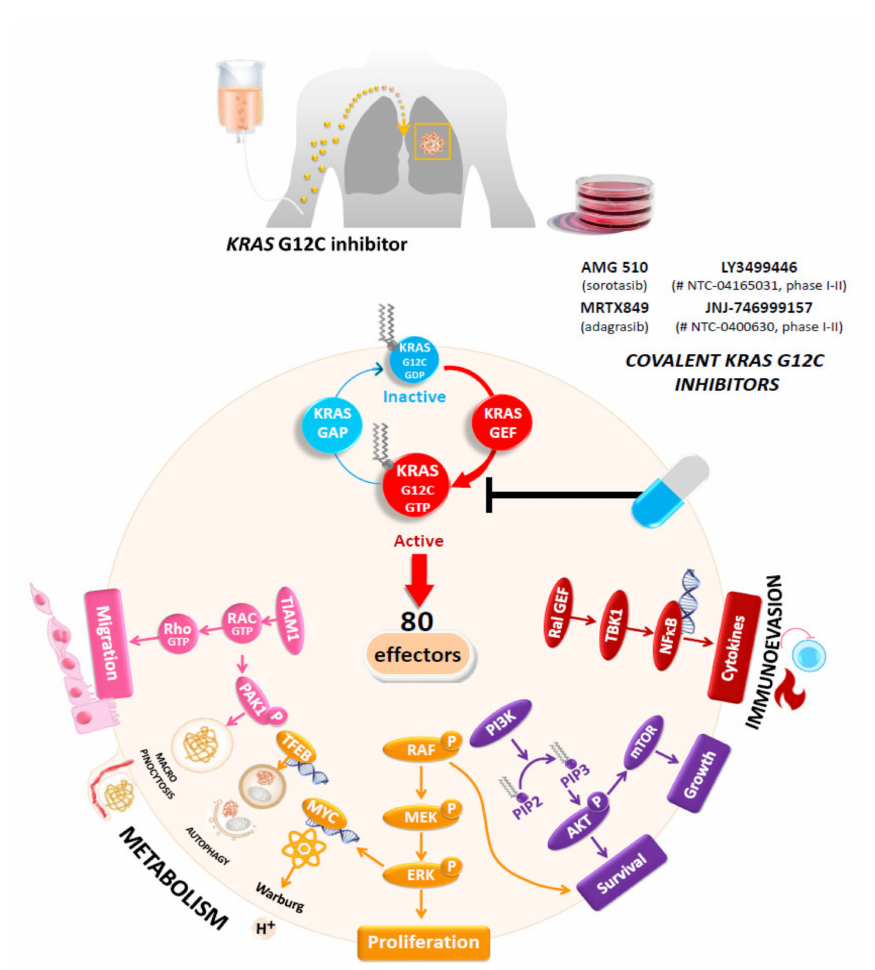
Figure 1. The promise of KRAS G12C inhibitors. Compared with wild-type KRAS , cysteine 12 (C12) mutations destroy the GTPase activity of KRAS and lock it in the GTP-bound state. Once activated, Ras signals through 80 effectors, thus activating many different signaling pathways involved in cell proliferation, survival, metabolism, and migration. The best-characterized pathways are the MAPK (Raf-MEK-ERK), PI3K/AKT, and Ral pathways. In contrast, the small molecule drugs sotorasib and adagrasib can form a covalent bond with C12 in the KRAS-G12C protein, causing KRAS to take on an inactive